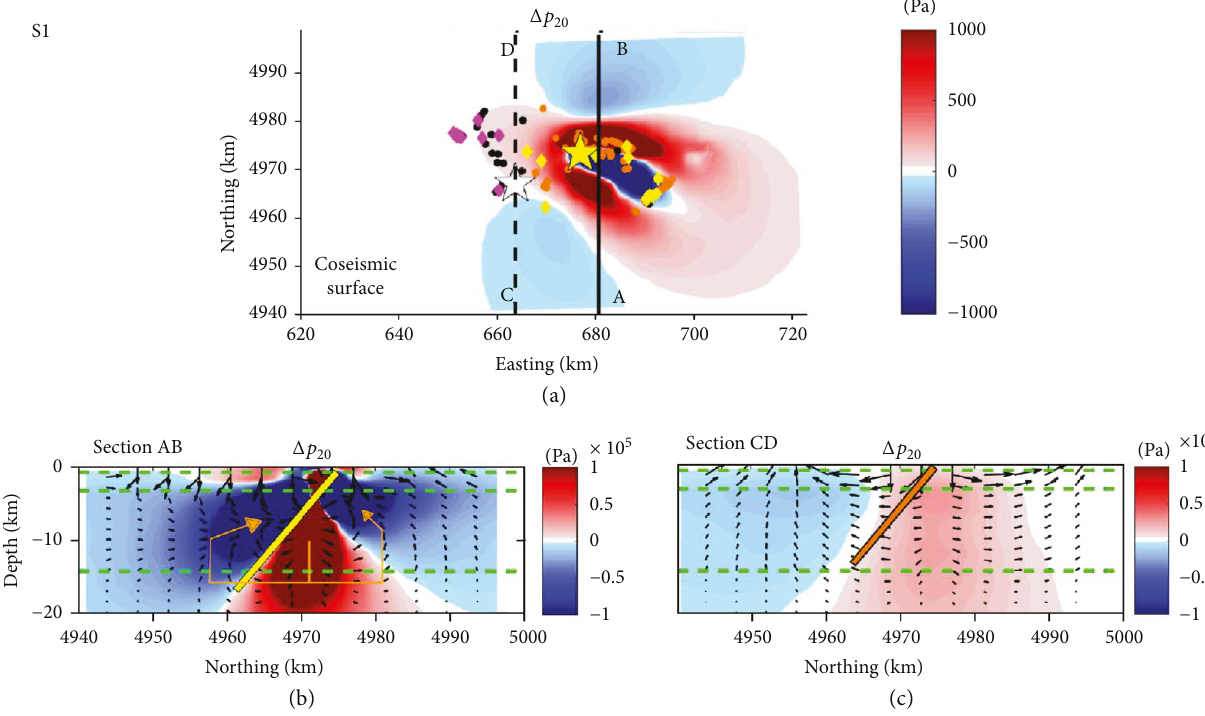
Figure 4: Coseismic pore pressure, Δ p computed at the surface (a), in section AB (b), and in section CD (c) for scenario S1. Red: pore- 20 pressure increase (i.e., compressive zones). Black arrows: fl uid fl ow direction (logarithmic scale). Yellow (orange) line: intersections with the Ferrara (Mirandola) fault. Orange arrows: schematic fl uid fl ow direction. Orange (black) dots and yellow (magenta) diamonds: location of the episodes of liquefaction and water level changes in wells, associated with the May 20 (May 29) earthquake. Except for the well data presented by Nespoli et al. [10] and Marcaccio and Martinelli [9], most changes in water levels are due to qualitative and sporadic observations performed in domestic wells, but they allow us to estimate the spatial scale on which the two earthquakes have in fl uenced the aquifer. Green dashed lines represent the elastic and hydraulic